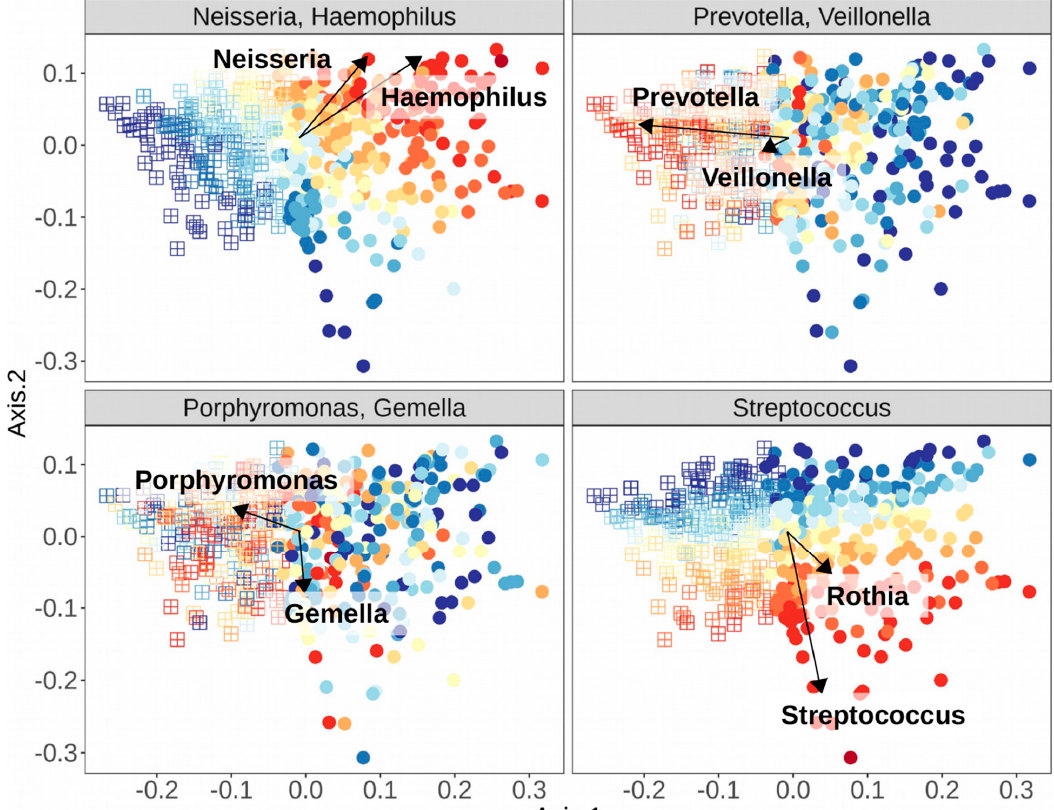
Figure 3. Gradients of abundances of consensus stomatotype-driving genera. Using a random subset of 500 samples from an oral microbiome dataset [10], samples were clustered into two stomatotypes using the weighted Unifrac distance measure. Type 1 samples are represented by circles and type 2 samples by squares. In each box, samples are colored by the total relative abundance of the indicated organisms. Overlaid are arrows indicating the tendency of the abundances of each organism noted in Table 3. In this subset of samples, Neisseria and Haemophilus strongly associate with stomatotype 1 samples, Prevotella strongly associates with stomatotype 2 samples while Veillonella does so weakly. The “variable stomatotype” drivers are indeed variable in their associations in this instance. Streptococcus shows a clear gradient but does not conform to either stomatotype. Gemella and Rothia , which have been shown to co-occur with Streptococcus in stomatotypes in the literature, do the same here, with Rothia more associated with stomatotype 1. However, Porphyromonas , which has been shown to co-occur with Streptococcus, Gemella , or Neisseria previously, associates with none of these here, and instead is strongly associated with stomatotype 2. Table 3. Consensus stomatotype-driving genera. Genera that have been shown in the literature to strongly drive the distinction between samples of oral microbiome datasets by differences in their abundances. The stomatotype numbers are arbitrarily assigned. The genera are listed in the second column, along with notes on associations between the organisms where relevant. The third column contains the references to the literature, which shows these stomatotype associations. Genus